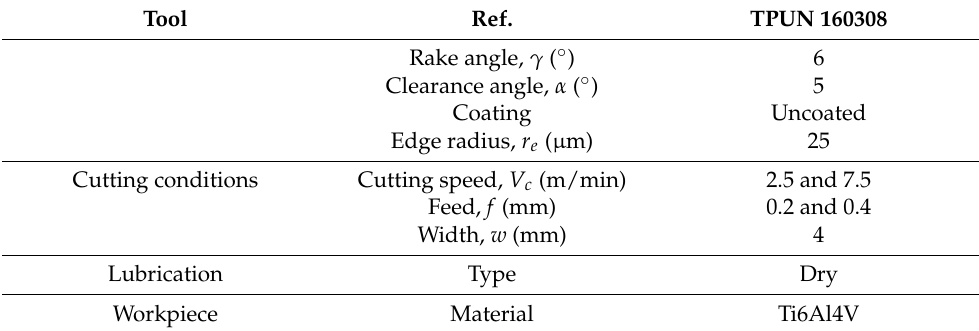
Table 6. Experimental